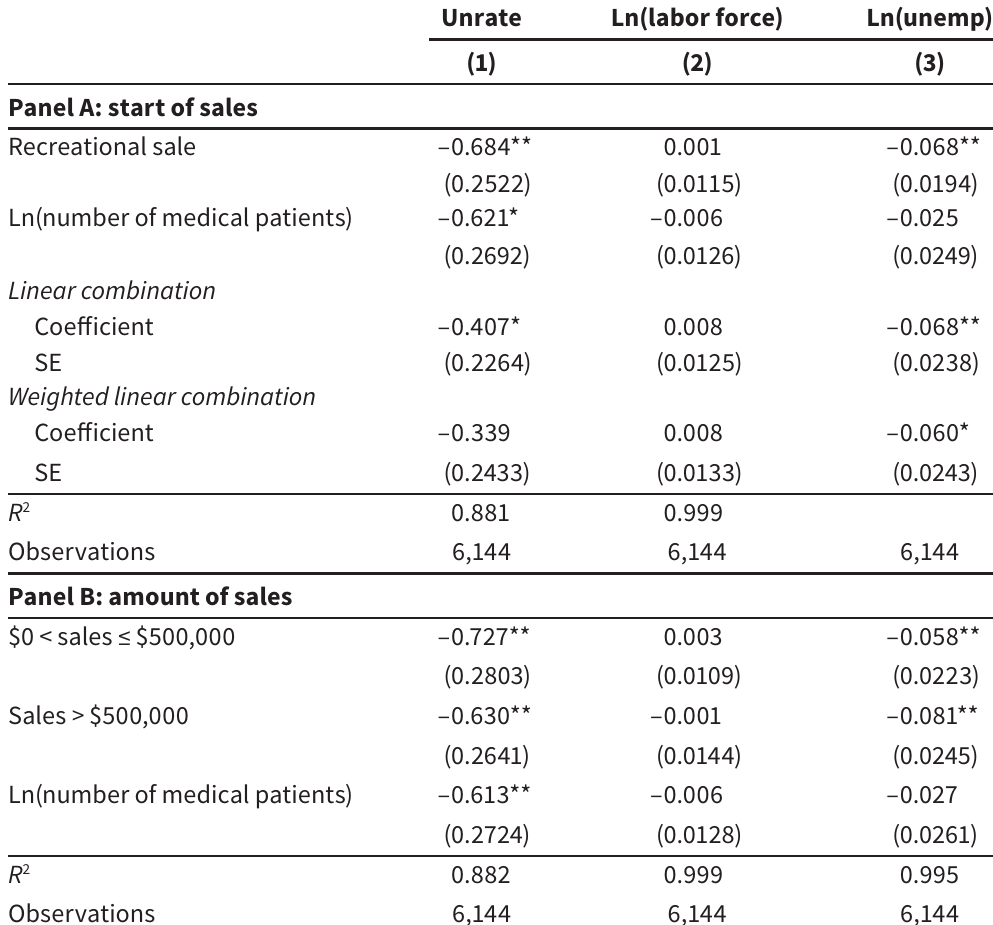
Effect of recreational dispensary entry and sales on the unemployment rate ( Unrate), Ln(labor force), and Ln(unemployed) – regression